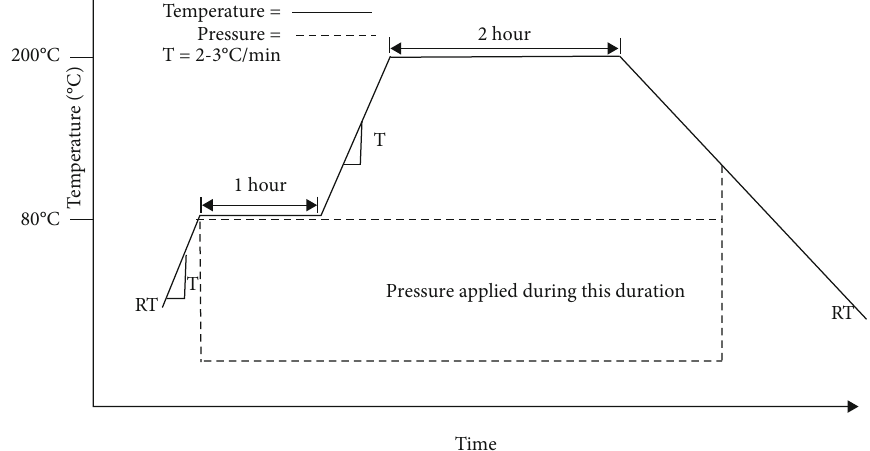
Figure 4: Composite curing cycle from room temperature (RT) to curing and cooling back